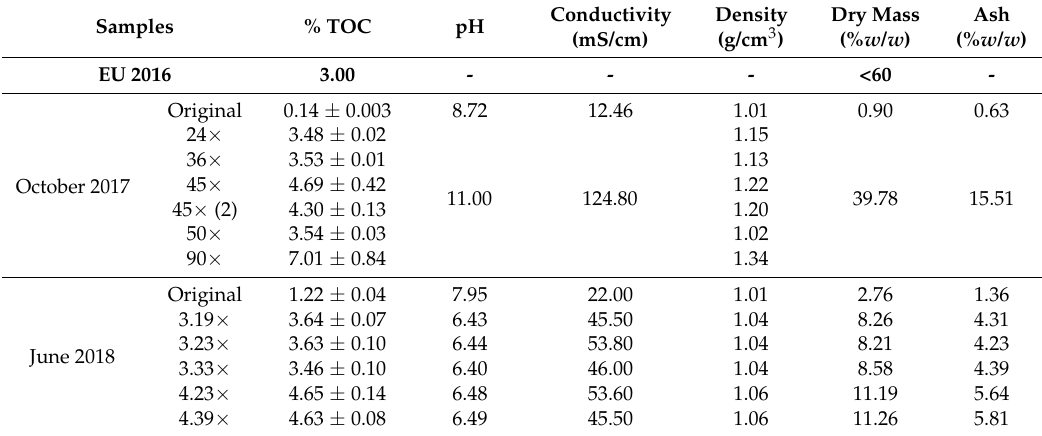
Table 1. Chemical properties of original and concentrated leachates (October 2017 and June